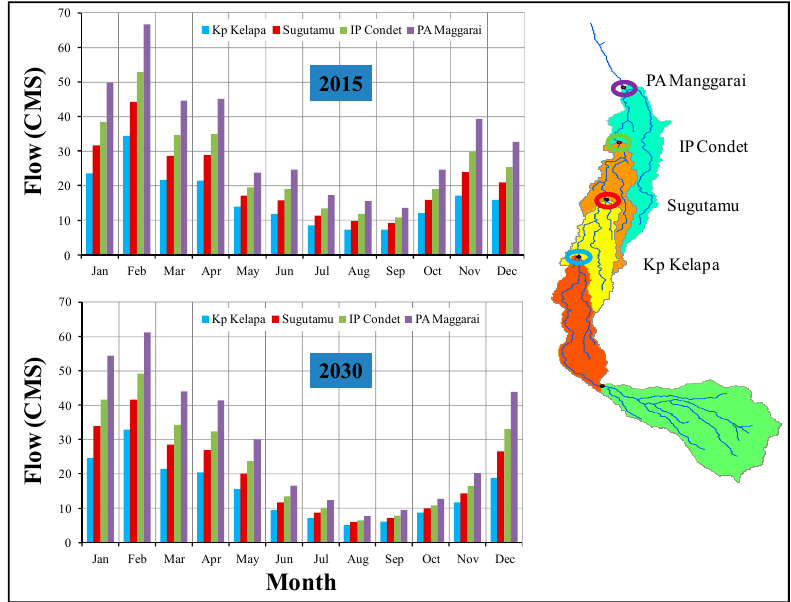
Figure 7. Comparison of the observed and simulated (output from WEAP) average monthly discharge at different stations for the years 2015 and 2030.